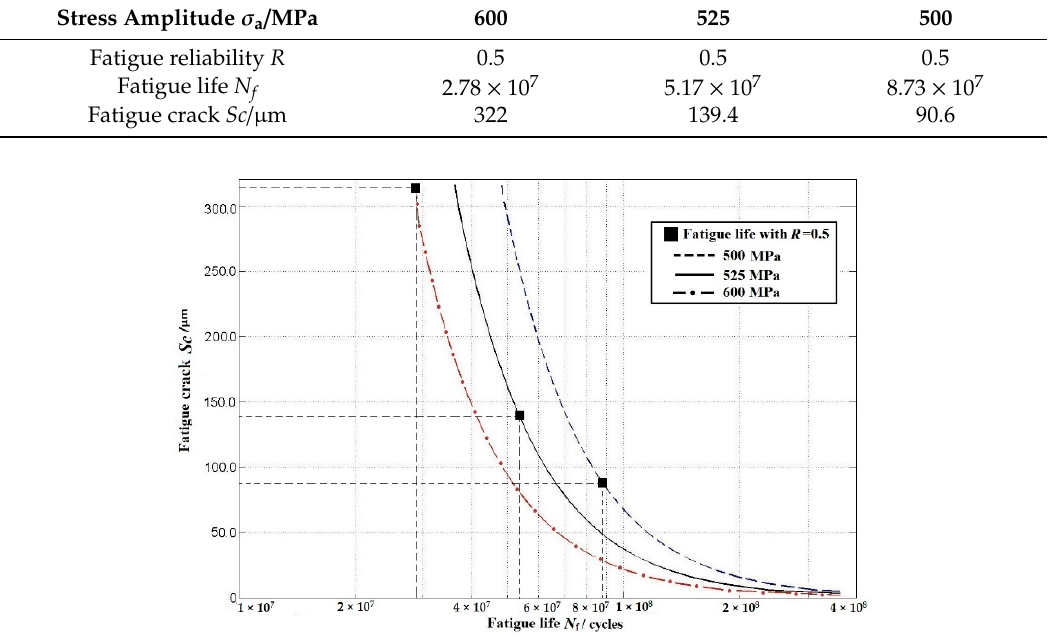
Figure 10. The fatigue life with R = 0.5.